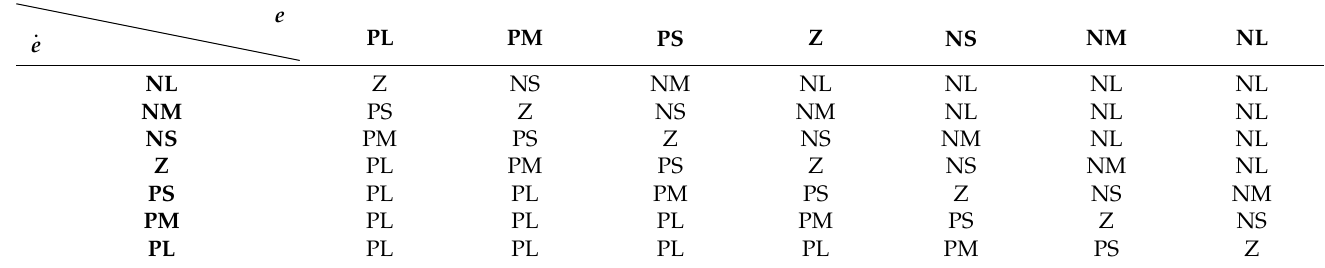
Table 2. General rule table with e and